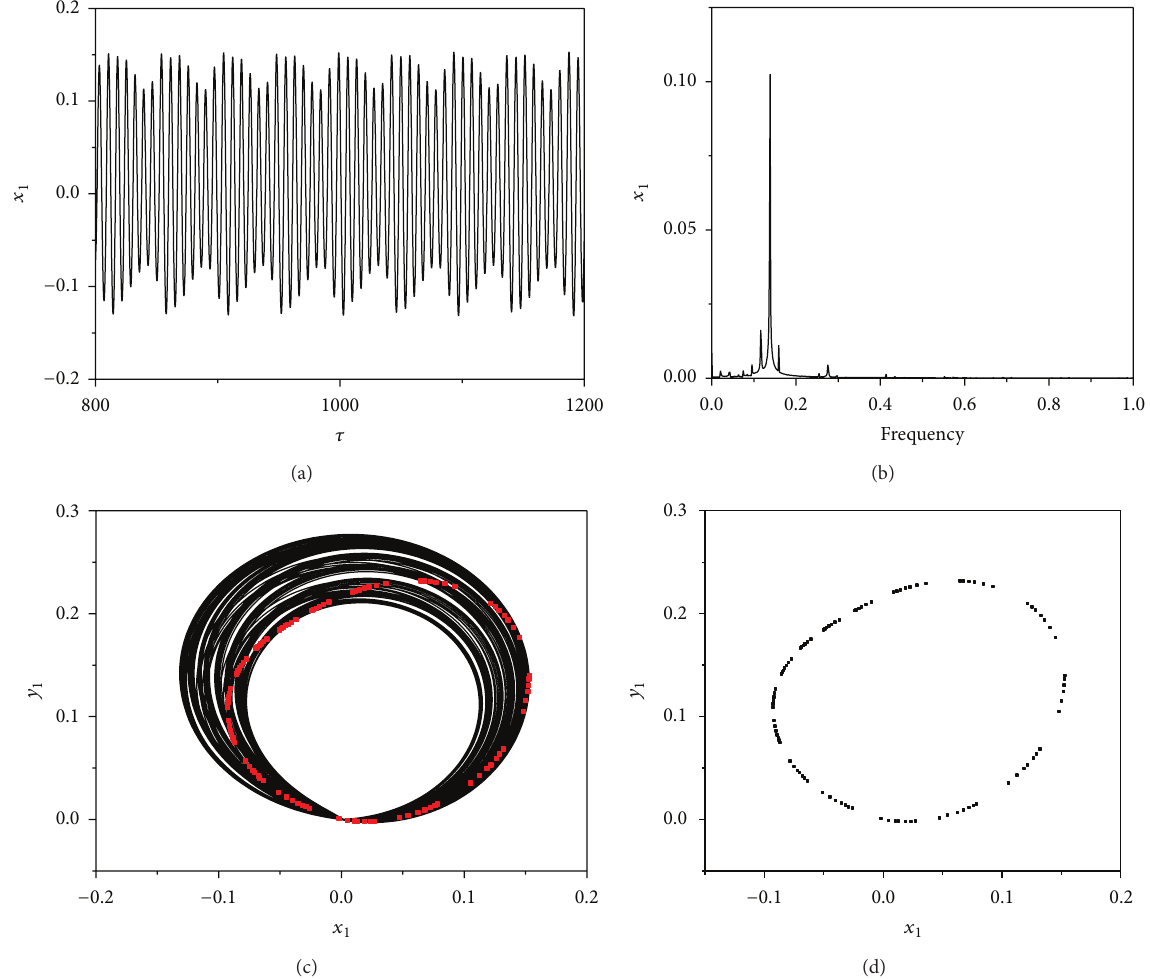
Figure 6: See 𝜔 = 0.78 . (a) Displacement response; (b) frequency spectrum; (c) rotor orbit; (d) Poincar´e